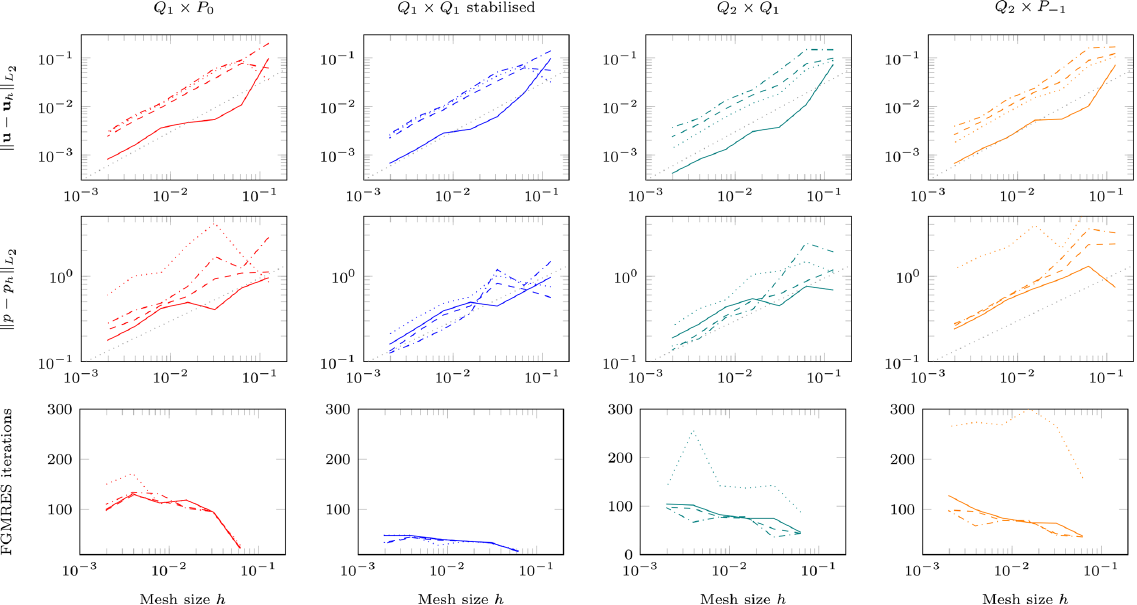
Figure 8. SolVi benchmark. Left to right: Q 1 × P 0 , stabilized Q 1 × Q 1 , Q 2 × Q 1 , and Q 2 × P − 1 . Top to bottom: velocity error, pressure error, and number of FGMRES iterations for the Stokes solve. The individual lines in each graph correspond to different ways of averaging coefficients on each cell: dotted lines use the correct unaveraged values of coefficients at each quadrature point; dash-dotted lines compute the arithmetic average of the values at the quadrature points on a cell and use the average for all quadrature points; dashed lines use the geometric average; solid lines use the harmonic average. The gray dotted line in the first two rows indicates O (h) convergence for velocity and O (h 0 . 5 ) for